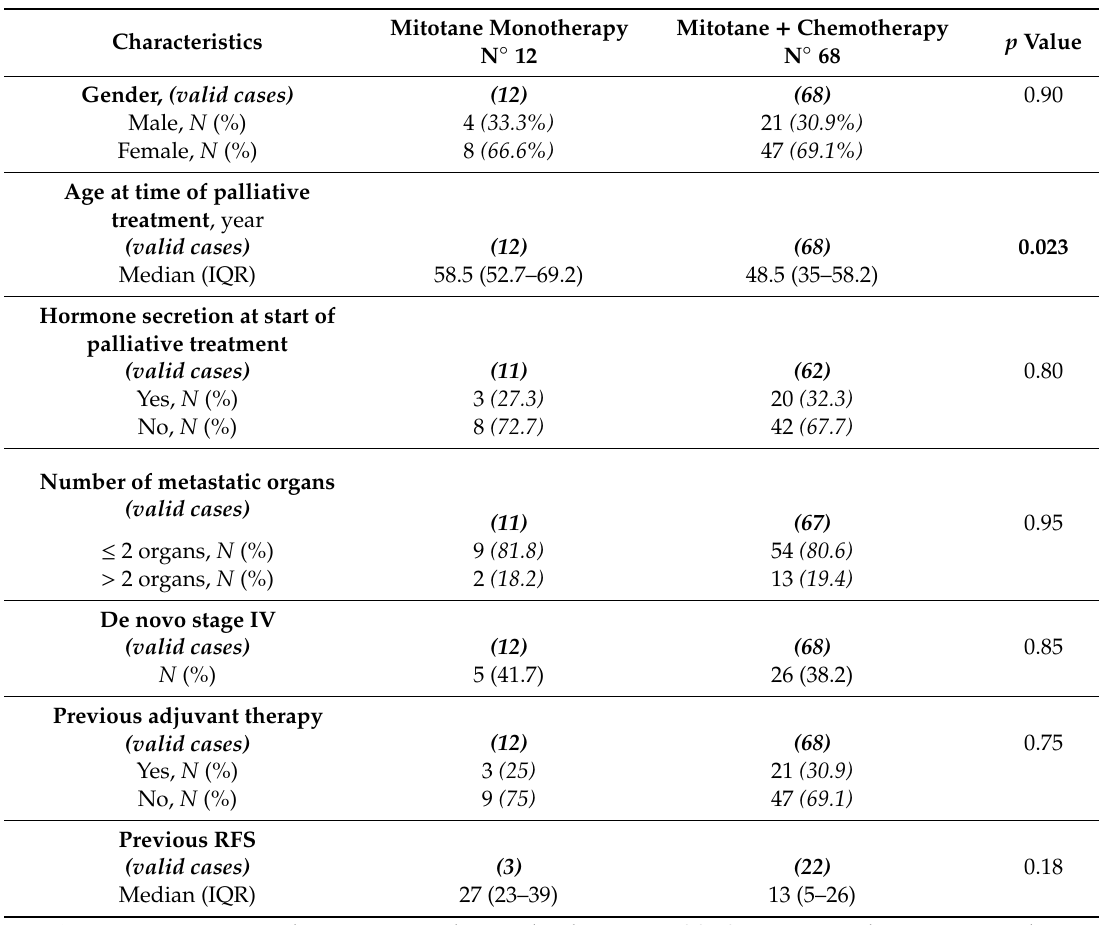
Table 3. Comparison between patients treated with mitotane monotherapy during all follow-up vs. patients treated with di ff erent lines of